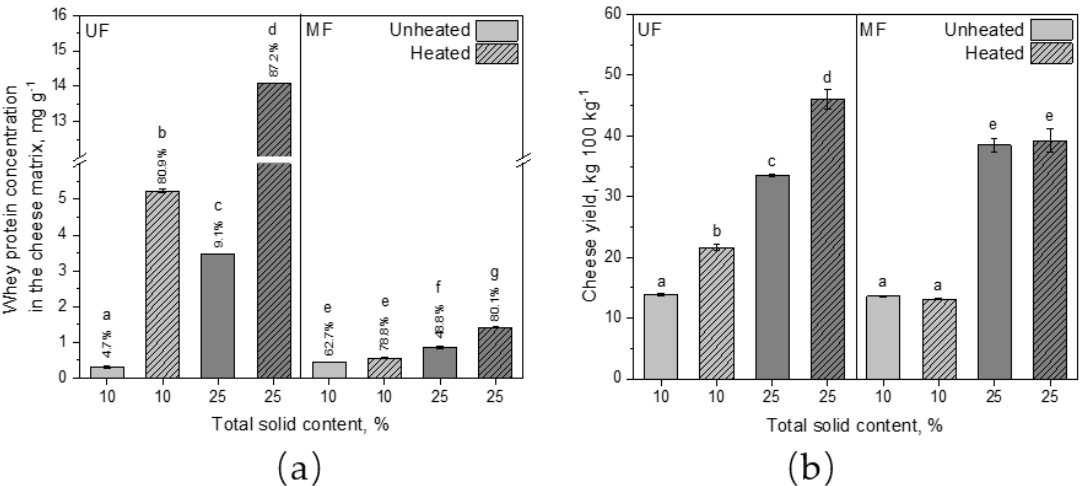
Figure 7. Whey protein concentration in the cheese matrix ( a ) and cheese yield ( b ) after incubation (t = 1 h, ϑ = 40 ◦ C) and centrifugation at 4000 × g (t = 45 min, ϑ = 20 ◦ C) of unheated and heated reconstituted UF and MF rennet gels with 10 and 25% total solid content. Letters indicate the statistical significance at p ≤ 0.05.